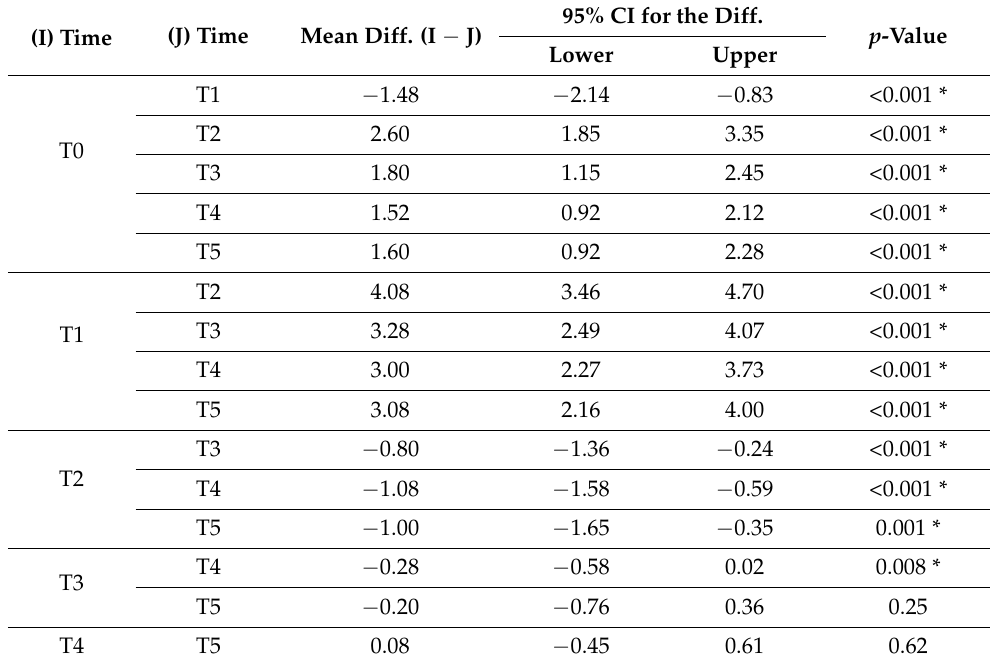
Table 3. Multiple comparisons of mean difference in VAS scores b/w time intervals in test group using Wilcoxon signed-rank post hoc test.